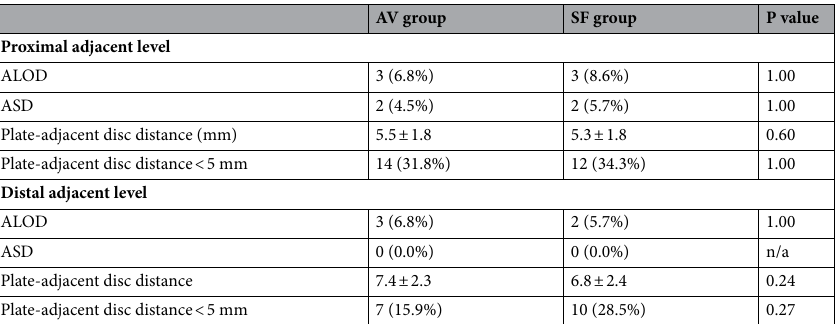
Table 3. Radiographic results regarding ALOD and ASD. ALOD, ASD, and plate-adjacent disc distance < 5 mm were analyzed using a chi-square test; Plate-adjacent disc distance was analyzed using a student’s t-test. AV all variable, SF selective fixed, ALOD adjacent level ossification development, ASD adjacent segmental disease, n/a not available.